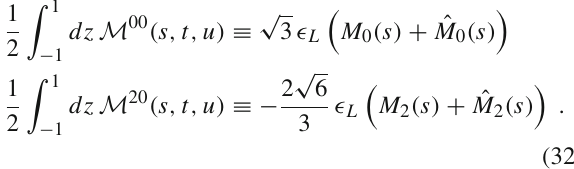
estimate is illustrated on Fig. 2 and compared with the chi- ral calculation at NLO. The dispersive evaluation displays a square-root singularity at s = ( m η − m π ) 2 induced by the ˆ ˆ M 2 which M 0 , endpoint of the left-hand cut in the functions overlaps with the right-hand cut as a result of the instability of the η . As a further consequence, the phase of the partial- ˆ M I violate Watson’s theorem and do not cancel waves M I + such that the discontinuity has both with the phases of h I 0 , ++ a real and an imaginary part.